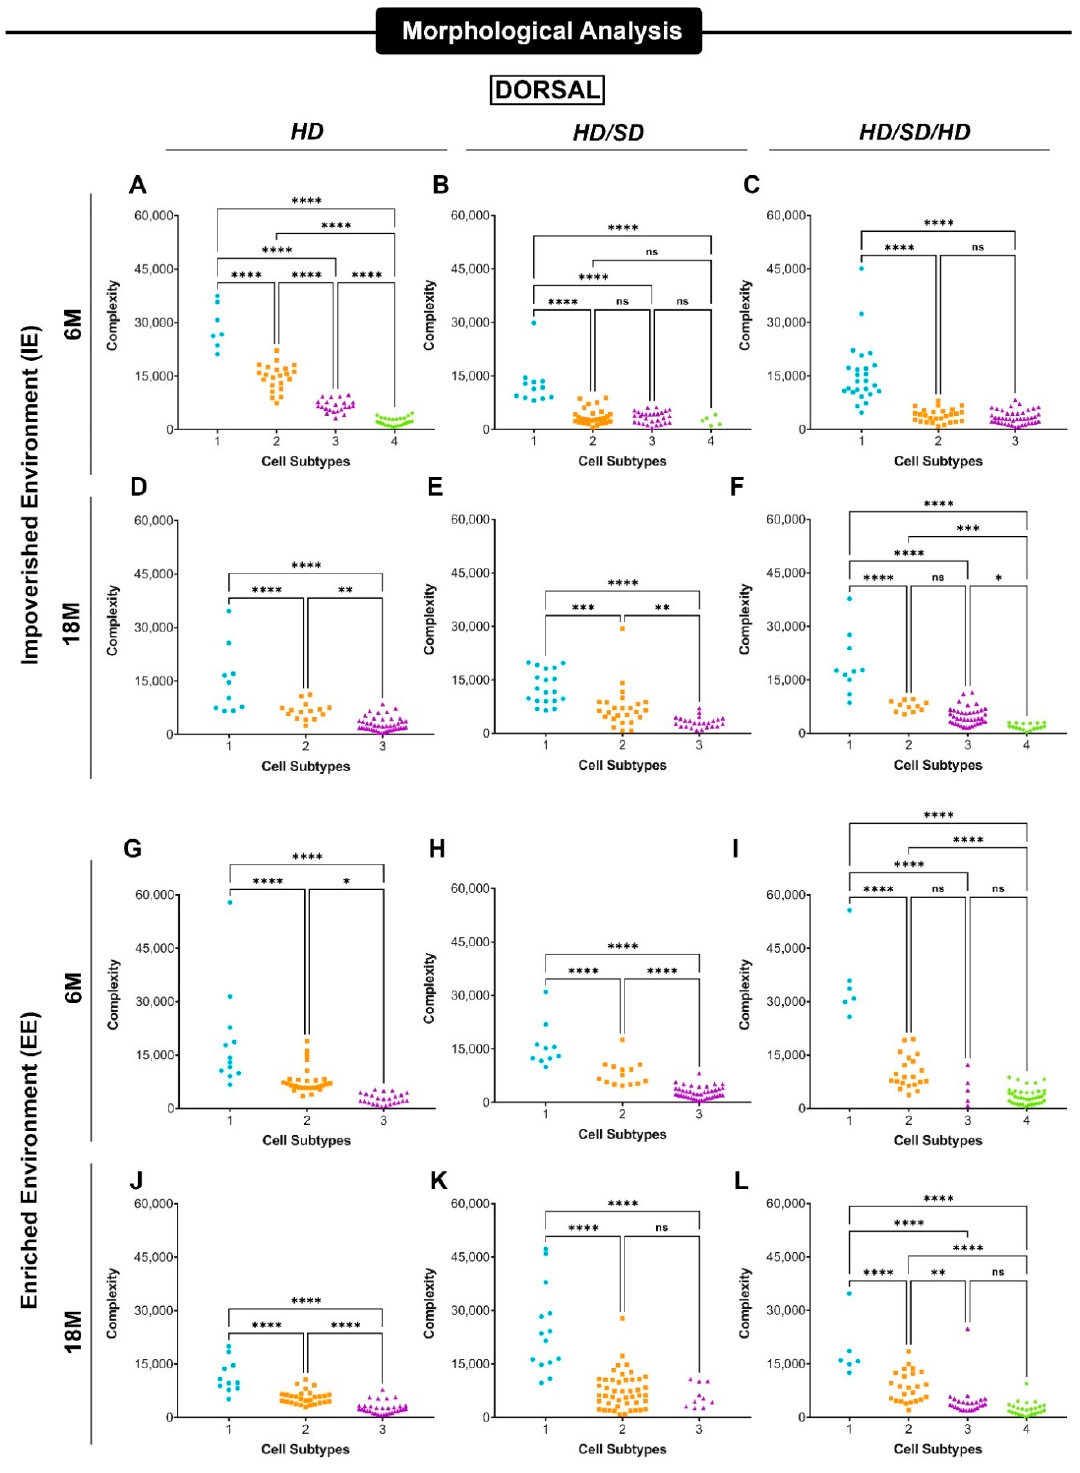
Figure 4. Mean values of astrocyte morphological phenotypes based on the cell arborization complexity at the external one-third of the molecular layer of the dorsal dentate gyrus. Impoverished environment—IE ( A – F ); Enriched environment—EE ( G – L ) age (6M—6-month-old; 18M—18-month-old) and masticatory regimen (HD, HD/SD, and HD/SD/HD). Morphological complexity is expressed as Mean/SD. Astrocyte morphotypes are indicated as 1–4 under each colored dataset. HD: hard diet/pellet; SD: soft diet/powder food; GFAP. * p < 0.05, ** p < 0.01, *** p < 0.001 and **** p < 0.0001; ns, not significant.